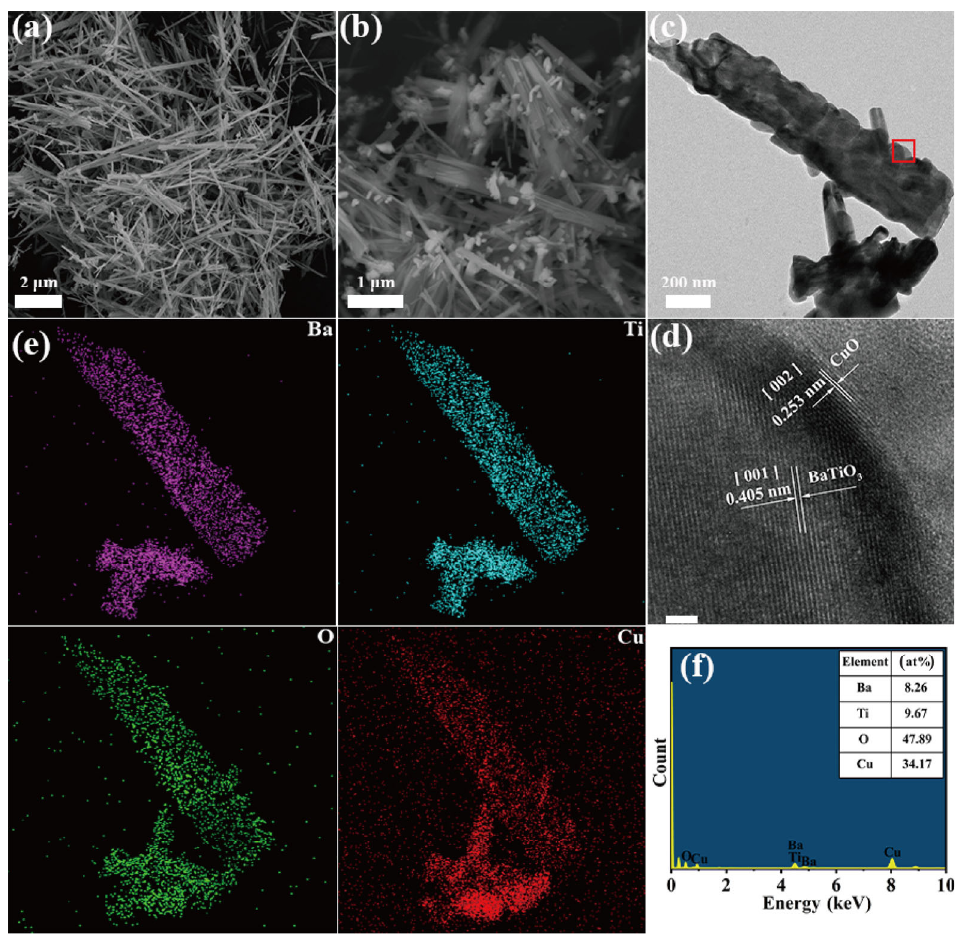
Fig. 2 SEM images of (a) BaTiO 3 NWs and (b) BaTiO 3 –0.6CuO heterostructures; (c) TEM and (d) HRTEM images of BaTiO 3 –0.6CuO; and (e) EDS spectra and (f) corresponding elemental mappings of BaTiO 3